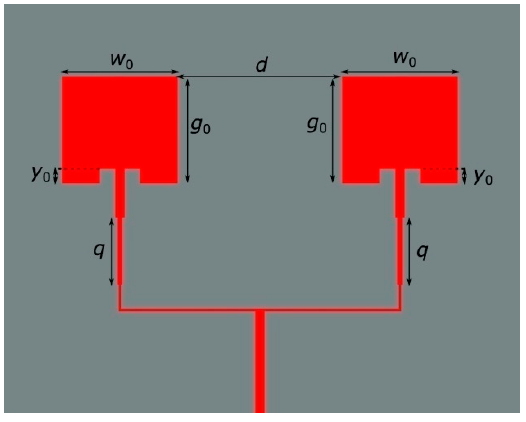
Figure 1. Patch antenna array design for the frequency of 3.4 GHz—Top view.